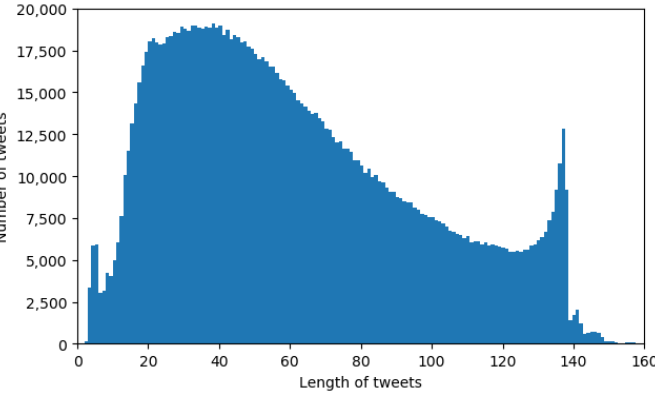
Figure 7. Histogram with lengths of the tweets of the